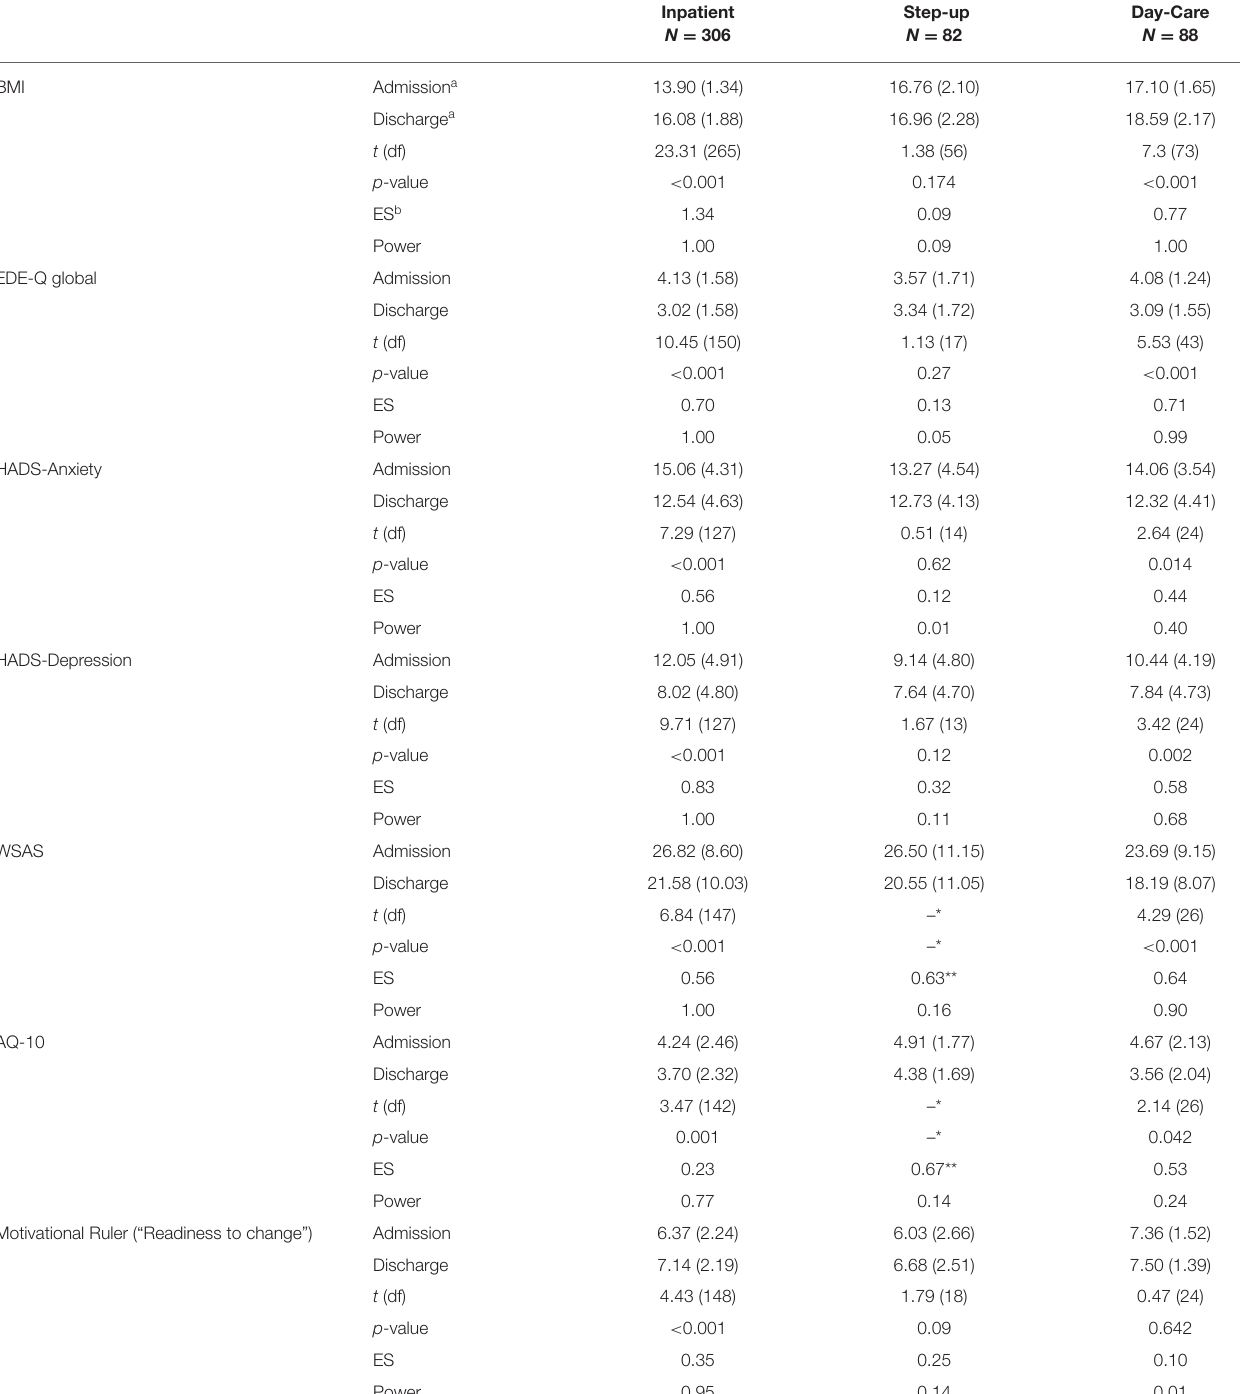
TABLE 2A | Admission and discharge outcome comparison for IP, SU, and